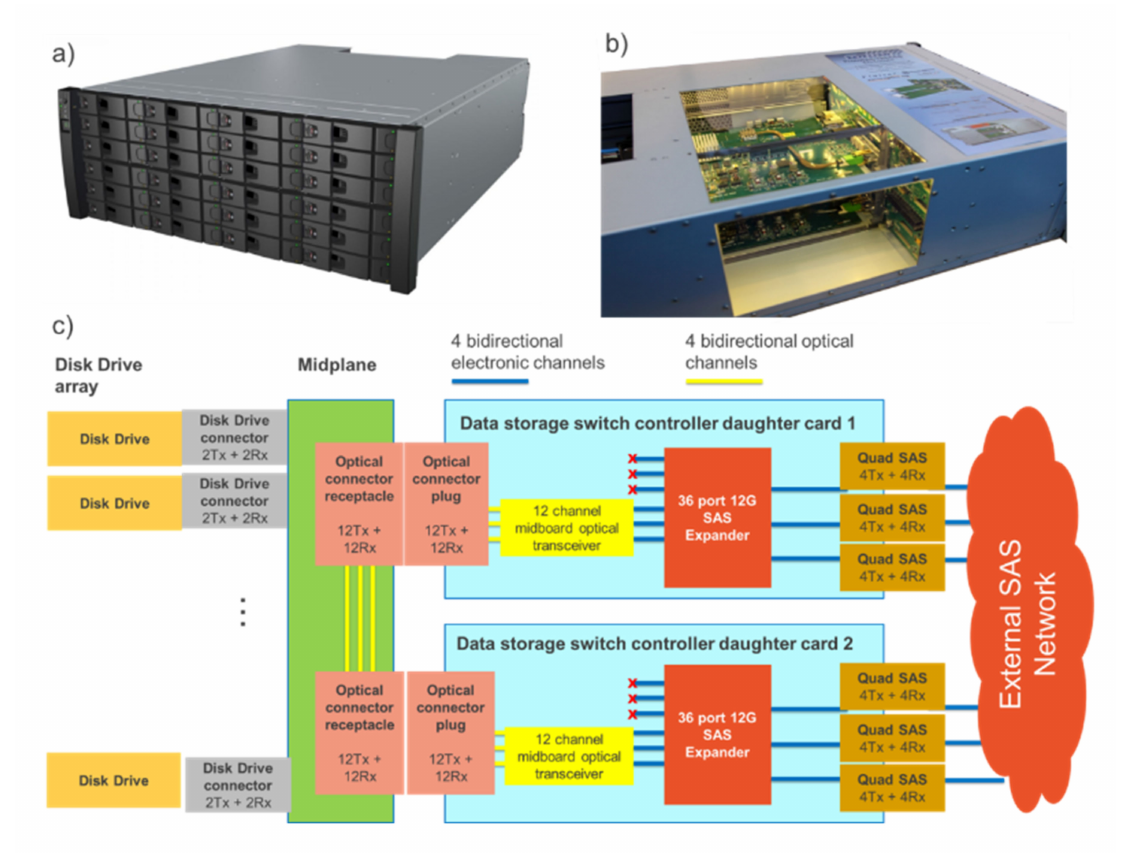
Figure 4. Partially optically enabled data storage system (LightningValley): ( a ) standard 4U24 OneStor storage array system by Seagate Technology, ( b ) photo of LightningValley system, ( c ) schematic view of optically enabled storage system